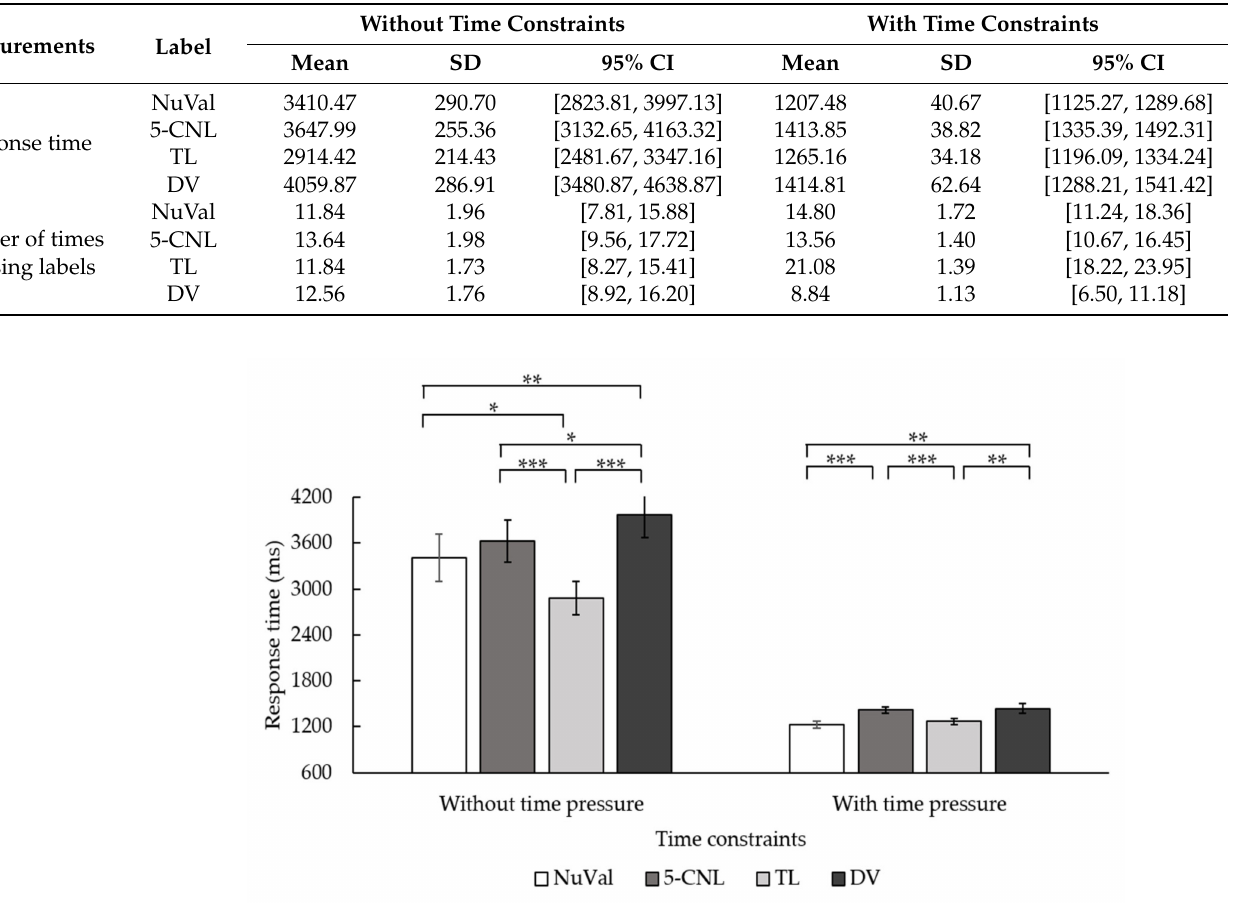
Figure 6. Interaction between the time constraints and types of nutrition labels in terms of the response time in Experiment 2. The error bar stands for the standard error. * represents that p < 0.05. ** represents that p < 0.01. *** represents that p <